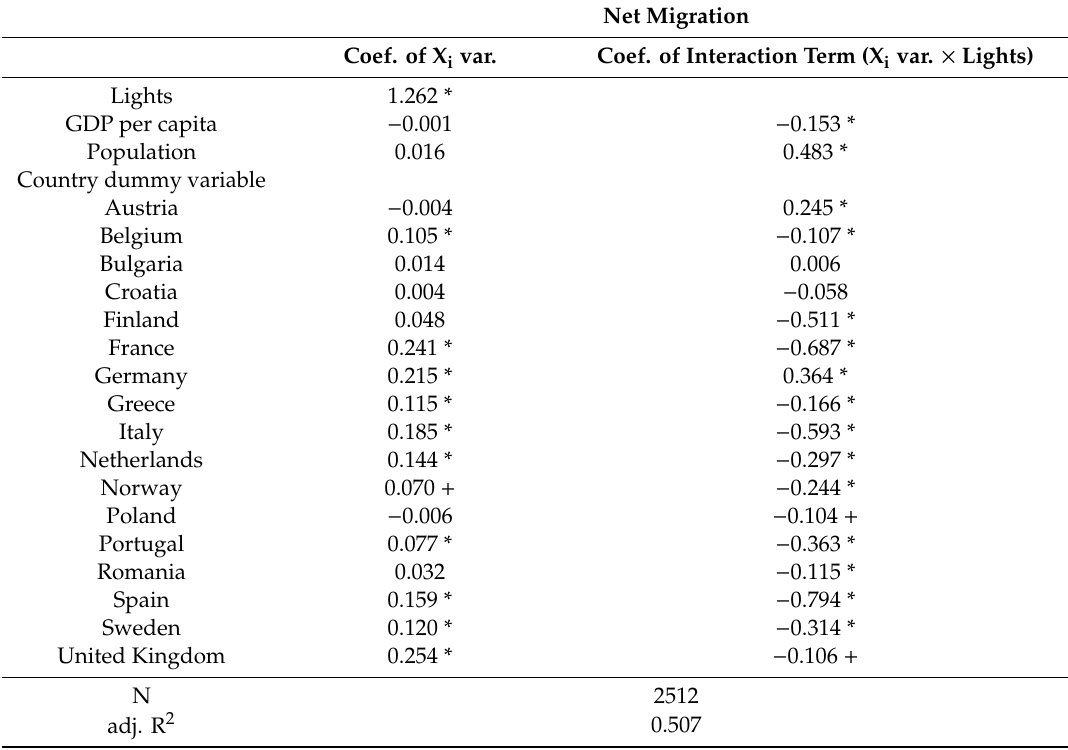
Table 5. Regression results of interaction terms between lights and other predictors.